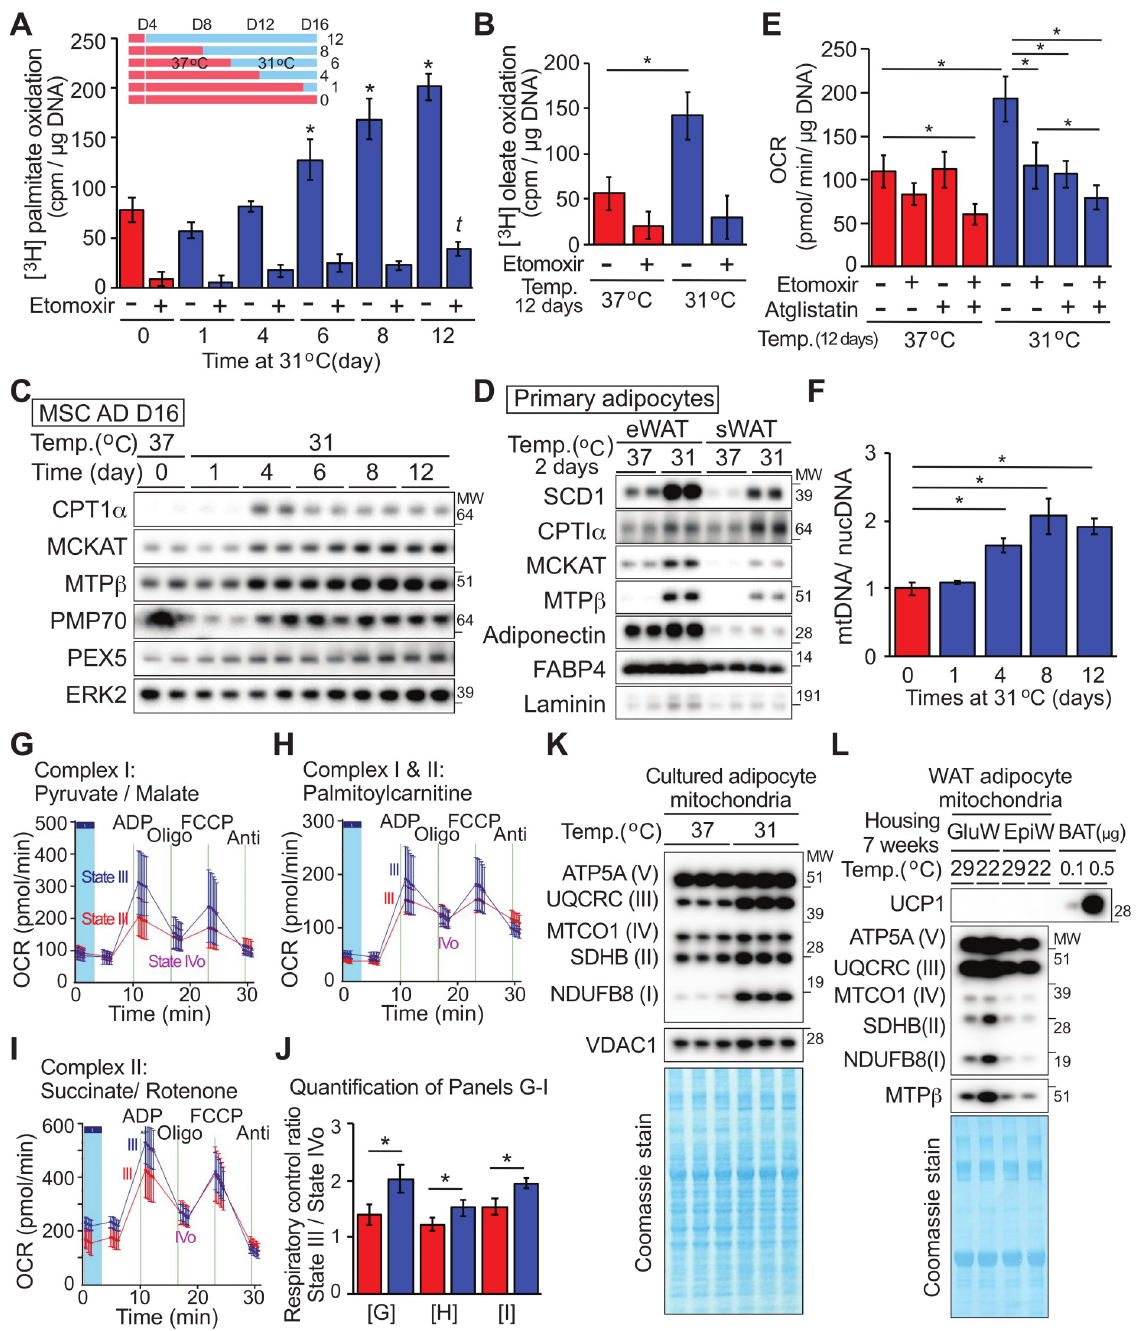
Fig 5. Cool adaptation of adipocytes stimulates β -oxidation of fatty acids and increases number and functioning of mitochondria. ( A, B ) Adipocytes at indicated days of cool temperature exposure ( A ; n = 5) or for 12 days ( B ; n = 6) were incubated with tritiated palmitate ( A ) or oleate ( B ) for 3 hours +/ − 40 μ M etomoxir. � significantly different from day 0 control at 37˚C; p < 0.05). t indicates a difference from day 0 etomoxir treatment. ( C ) Cool adaptation increases mitochondrial fatty acid oxidation and peroxisomal proteins. ( D ) Primary adipocytes isolated from eWAT or sWAT were cultured in suspension at either 37˚C or 31˚C for 2 days. Expression of SCD1, CPT1 α , MCKAT, and MTP β was then determined by immunoblot analyses; adiponectin, FABP4, and laminin were loading controls. ( E ) Elevated basal OCR of adipocytes at 31˚C is partially dependent on oxidation of endogenous fatty acids. MSC-derived adipocytes cultured at 31˚C or 37˚C for 12 days were treated with vehicle, 20 μ M etomoxir and/or 20 μ M of atglistatin for 2 hours prior and during assay of OCR ( n = 8–10). ( F ) Four- day exposure at 31˚C stimulates an increase in mitochondrial number as assessed by qPCR for 2 mitochondrial regions (CytoB, Cox-TMS) and 2 nuclear genes (glucagon, β -globin; n = 3). ( G – I ) Isolated mitochondria from adipocytes adapted to 31˚C have improved functioning of